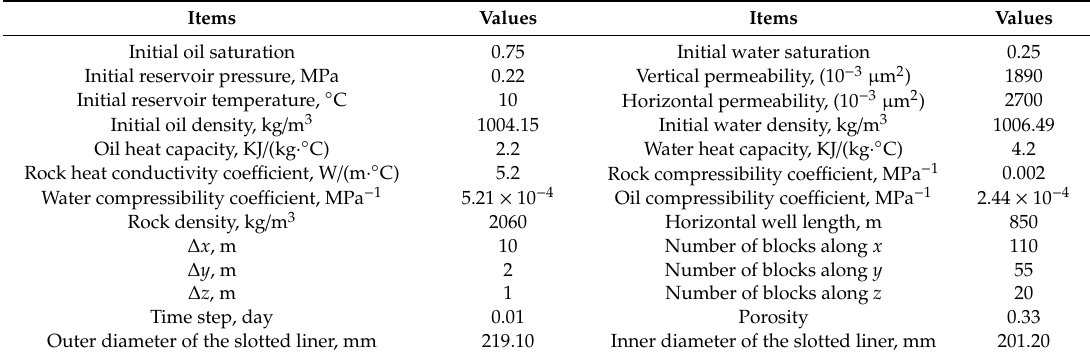
Table 2. Reservoir data used in the